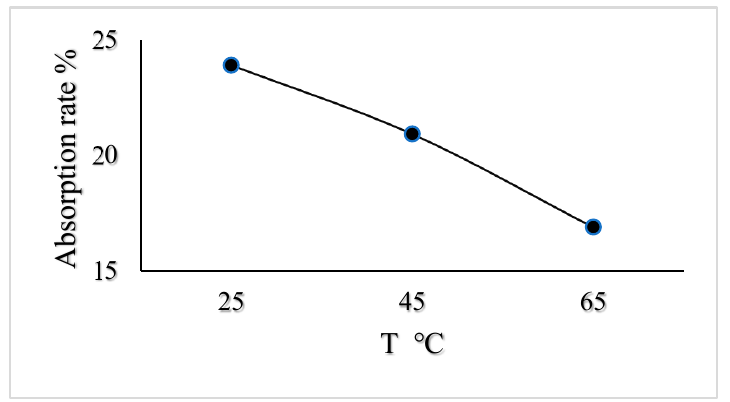
before entering the spray tower. Figure 6 shows the effect of exhaust gas temperature on the CO 2 absorption rate.